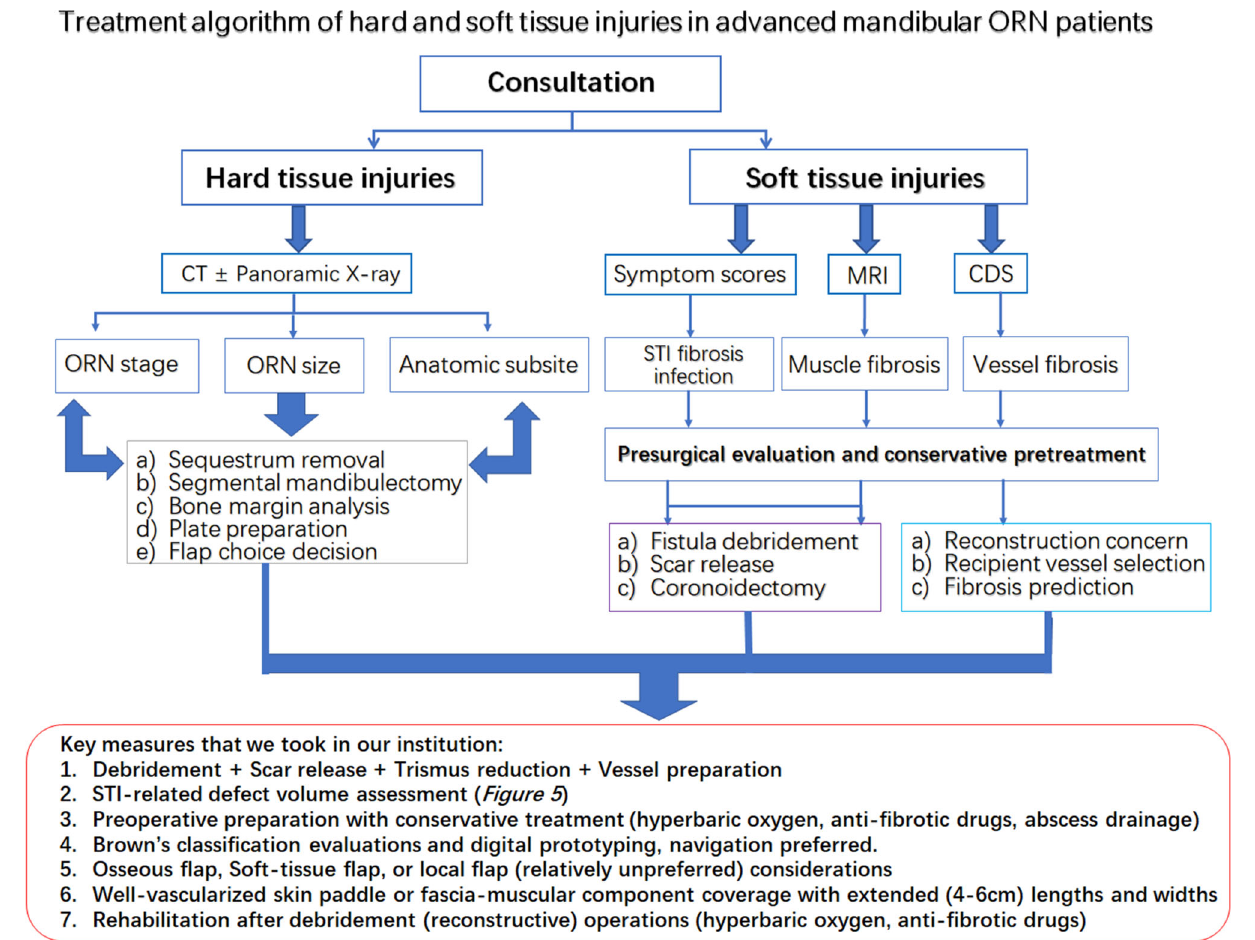
FIGURE 6 | The treatment algorithm for hard and soft tissue injuries in the advanced mandibular ORN patients. Red rectangular frame: The key measures taken in our institution for both bone and STI